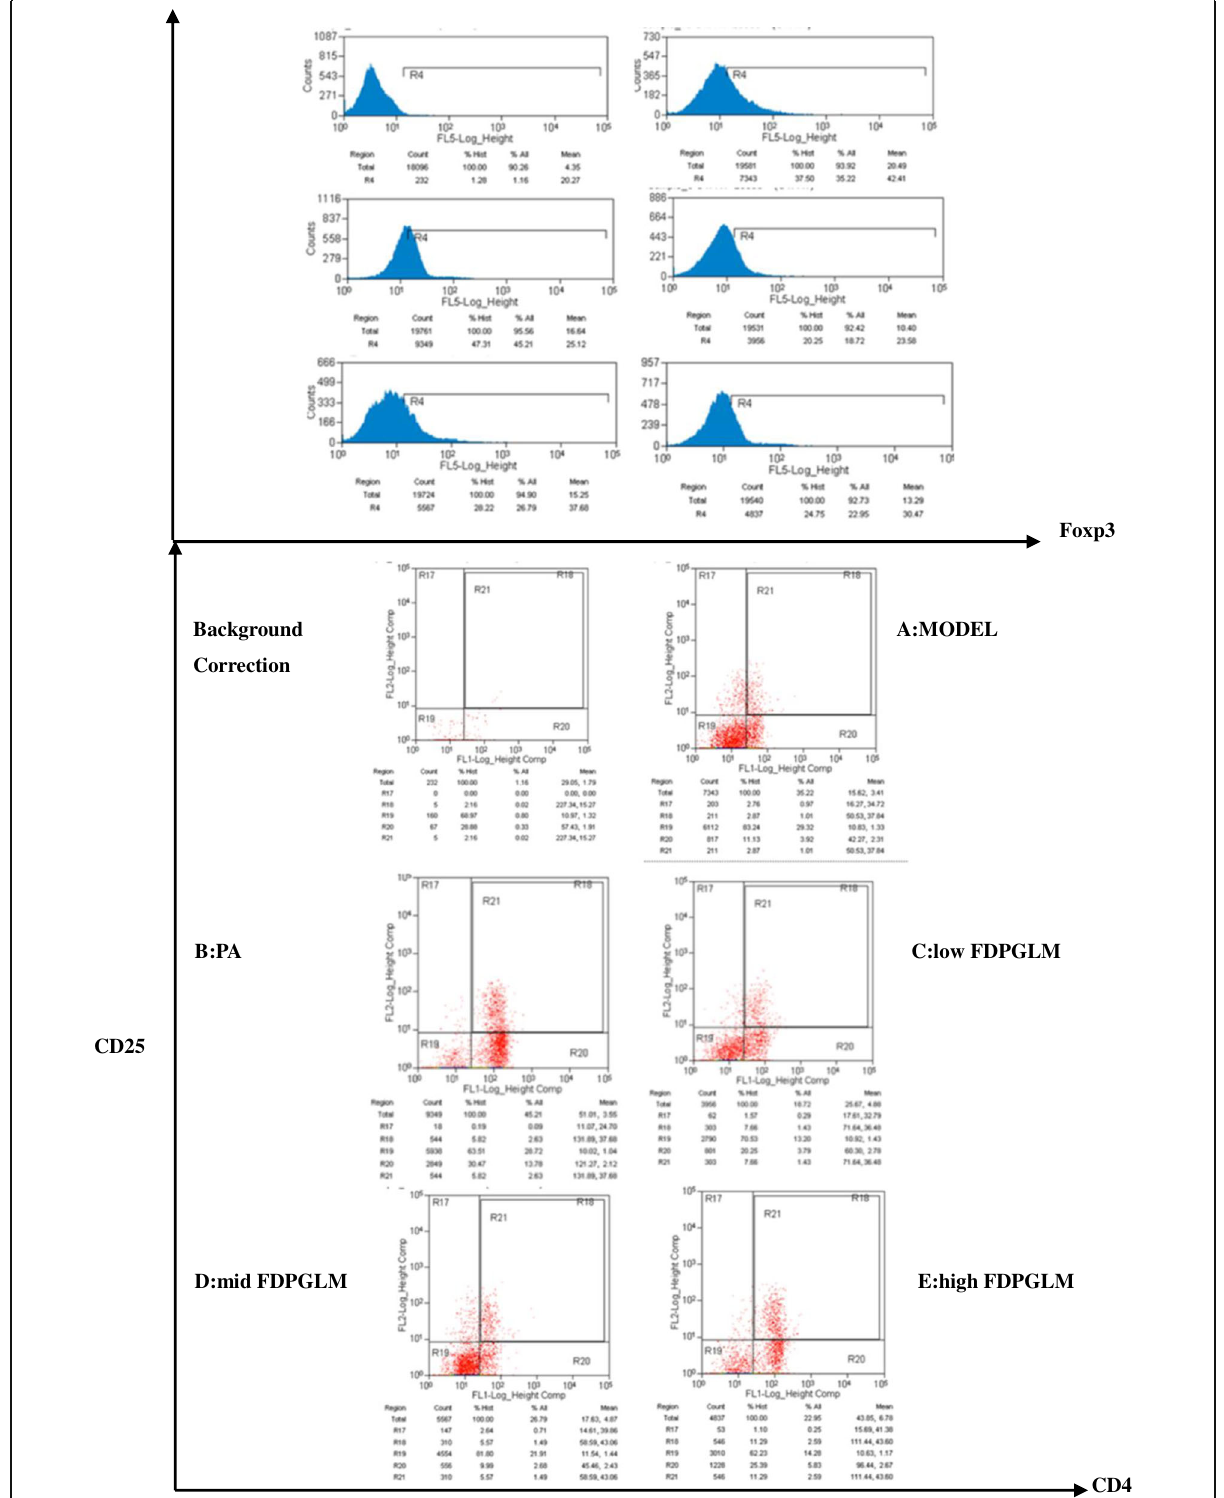
Fig. 3 The effect of FDPGLM on the differentiation of CD4 + CD25 + Foxp3 + Tregs in peripheral blood as detected by flow cytometry using three different; fluorescent labels. Representative dot plots from the FC analysis of three staining for CD4, CD25 and foxp3. Lymphocytes from peripheral blood were gated based on